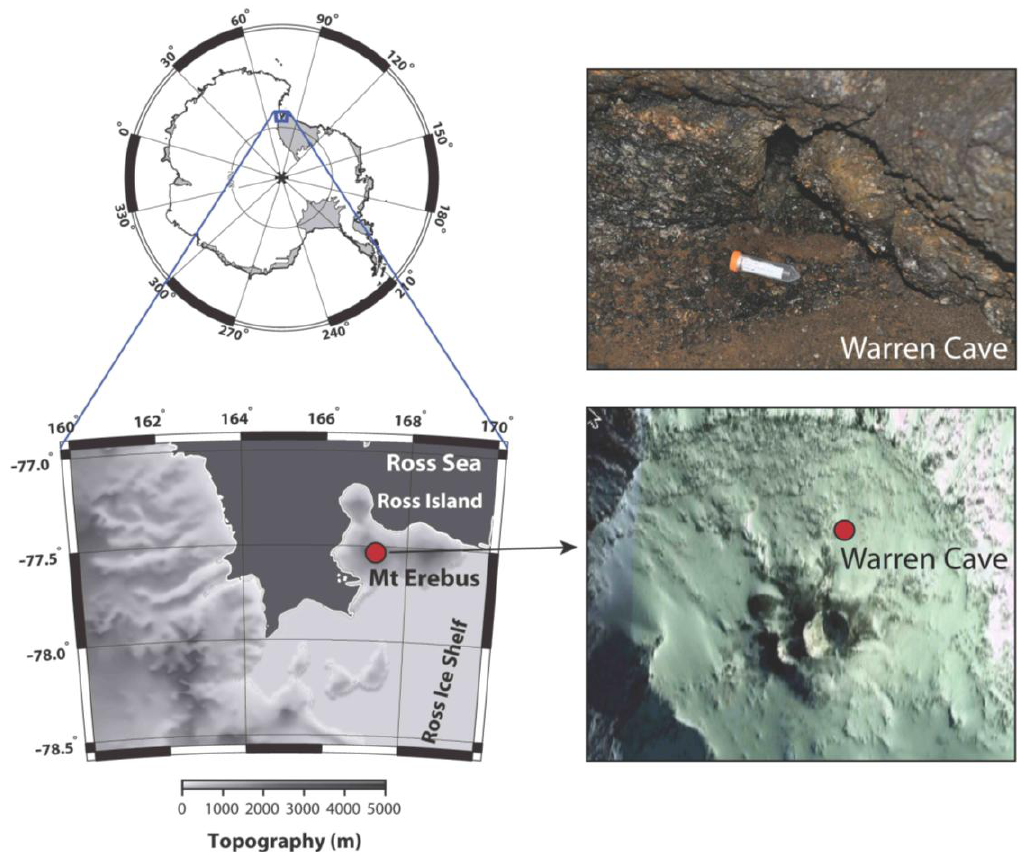
Figure 1. Warren Cave near Mt. Erebus Summit. The map shows the upper section of Mt. Erebus and the location of Warren Cave. The insert photo shows the site where the sample was